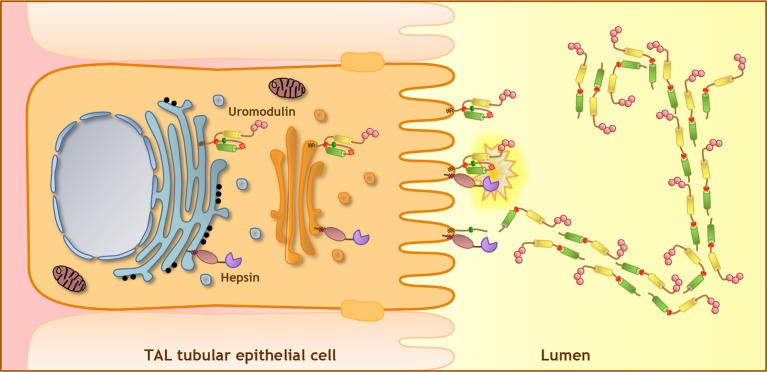
Model of uromodulin shedding and polymerisation.Uromodulin is exclusively expressed by TAL tubular epithelial cells. The protein enters the secretory pathway and reaches the plasma membrane in a polymerisation-incompetent conformation. This is ensured by the interaction between two hydrophobic patches within and next to the ZP-C subdomain (Internal Hydrophobic Patch, red circle, and External Hydrophobic Patch, dark green circle) (Jovine et al., 2004; Schaeffer et al., 2009; Han et al., 2010). Shedding by hepsin at the uromodulin consensus cleavage site (red diamond), likely occurring at the plasma membrane, releases the hydrophobic interaction, generating polymerisation-competent species that are assembled into polymeric filaments within the tubular lumen. Pink circles indicate N-terminal EGF-like domains, yellow and green cylinders represent ZP-N and ZP-C subdomains. The orientation of uromodulin within polymers is hypothetical.